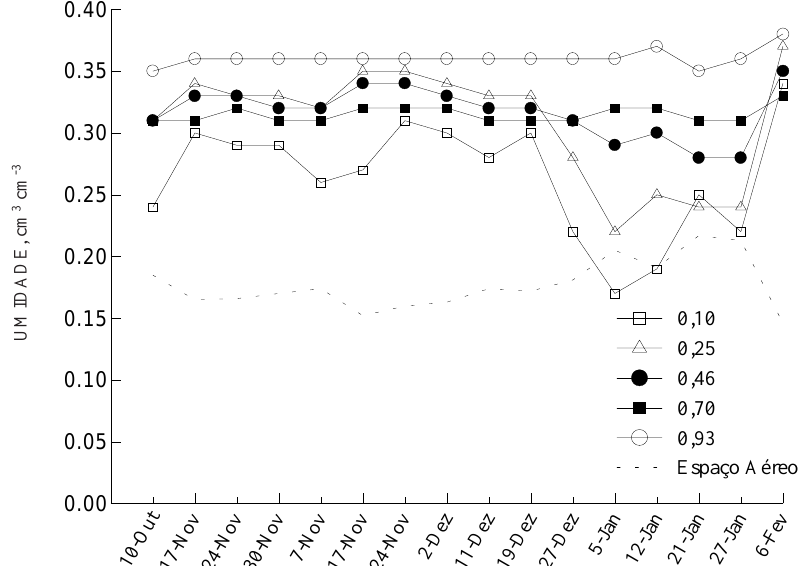
Figura 4. Variação temporal da umidade do solo determinada a 0,10, 0,25, 0,46, 0,70 e 0,93 m de profundidade e espaço aéreo na camada de 0,45 m. Cada ponto é a média das leituras dos dois perfis com horizonte A profundo